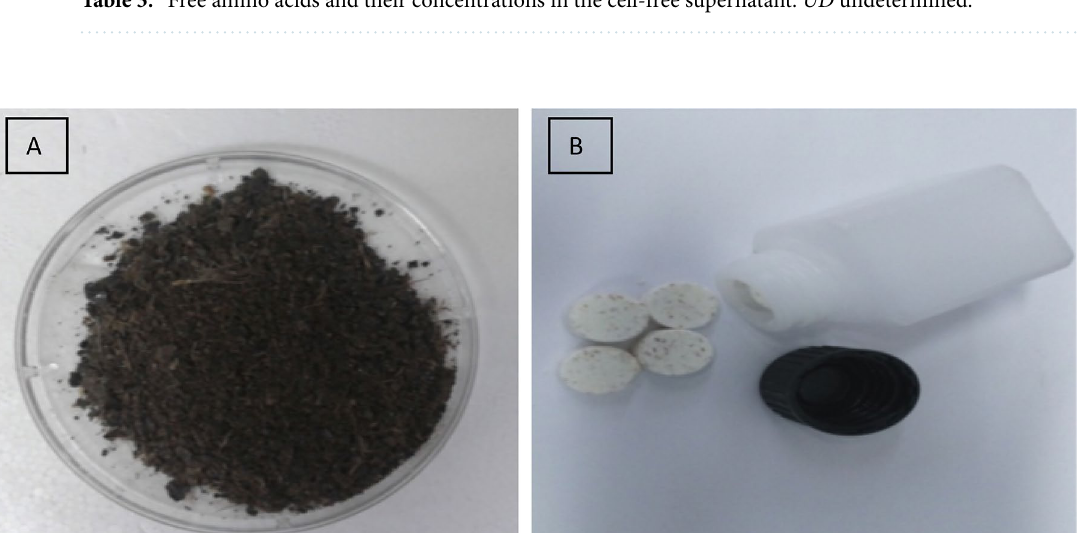
Table 3. Free amino acids and their concentrations in the cell-free supernatant. UD undetermined.